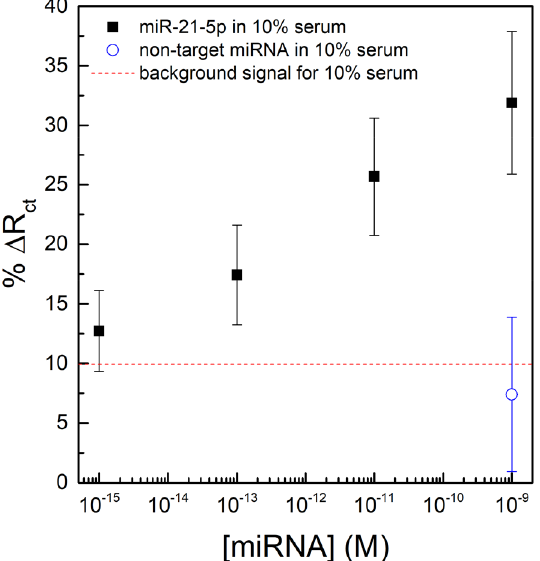
Figure 2. R ct variations upon incubations with 10% serum (red line), miR-21-5p diluted in 10% serum (black squares) and with 1 nM of a non-specific miRNA in 10% serum (open blue circle). The error bars represent the standard deviation for three separate